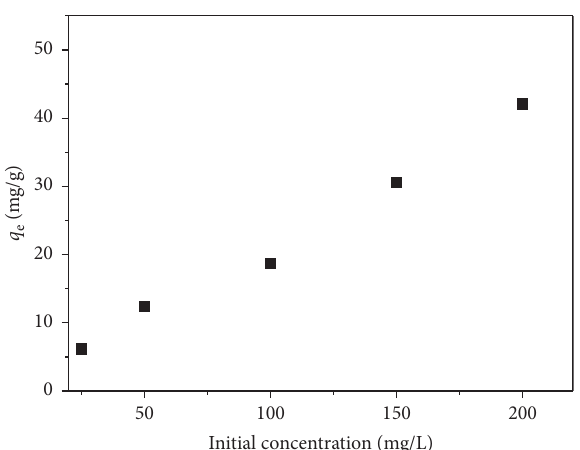
Figure 5: Effect of initial MO concentration ( t